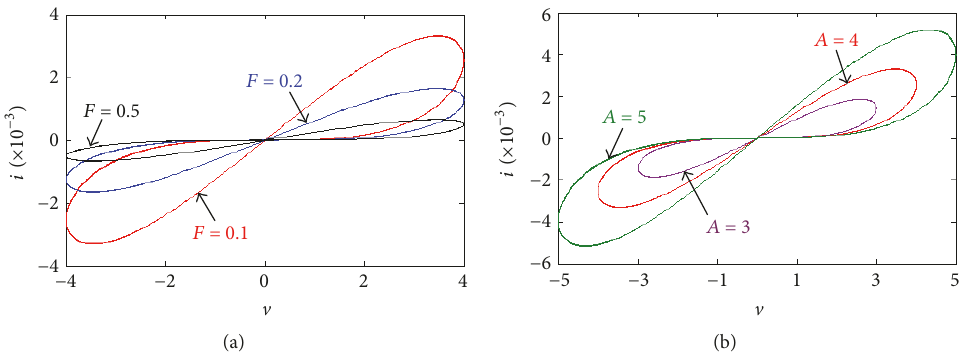
Figure 1: Pinched hysteresis loops of the flux-controlled ideal memristor. (a) 𝐴 = 4 with 𝐹 = 0.1 , 0.2, and 0.5. (b) 𝐹 = 0.1 with 𝐴 = 3 , 4, and 5.